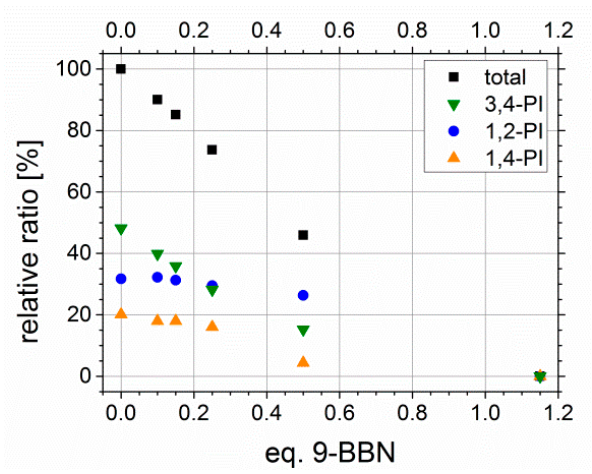
Figure 10. Conversion of polyisoprene double bonds in total, and divided according to microstructure (1,2 ‐ , 3,4 ‐ and trans ‐ 1,4 ‐ PI), depending on the used equivalents of 9 ‐ BBN. Used original polymers were S 41 I 5931 and S 51 I 495 .